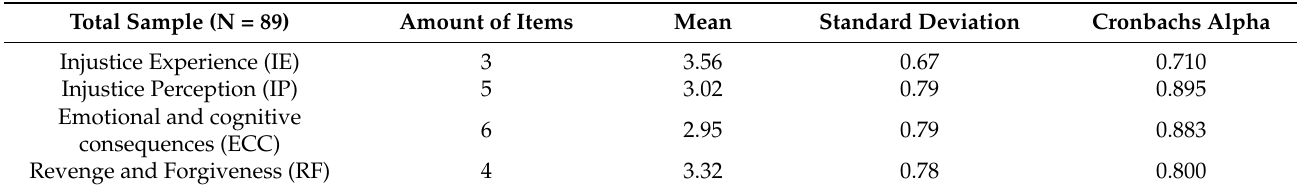
Table 2. Cronbach’s alpha and mean values for each subscale.